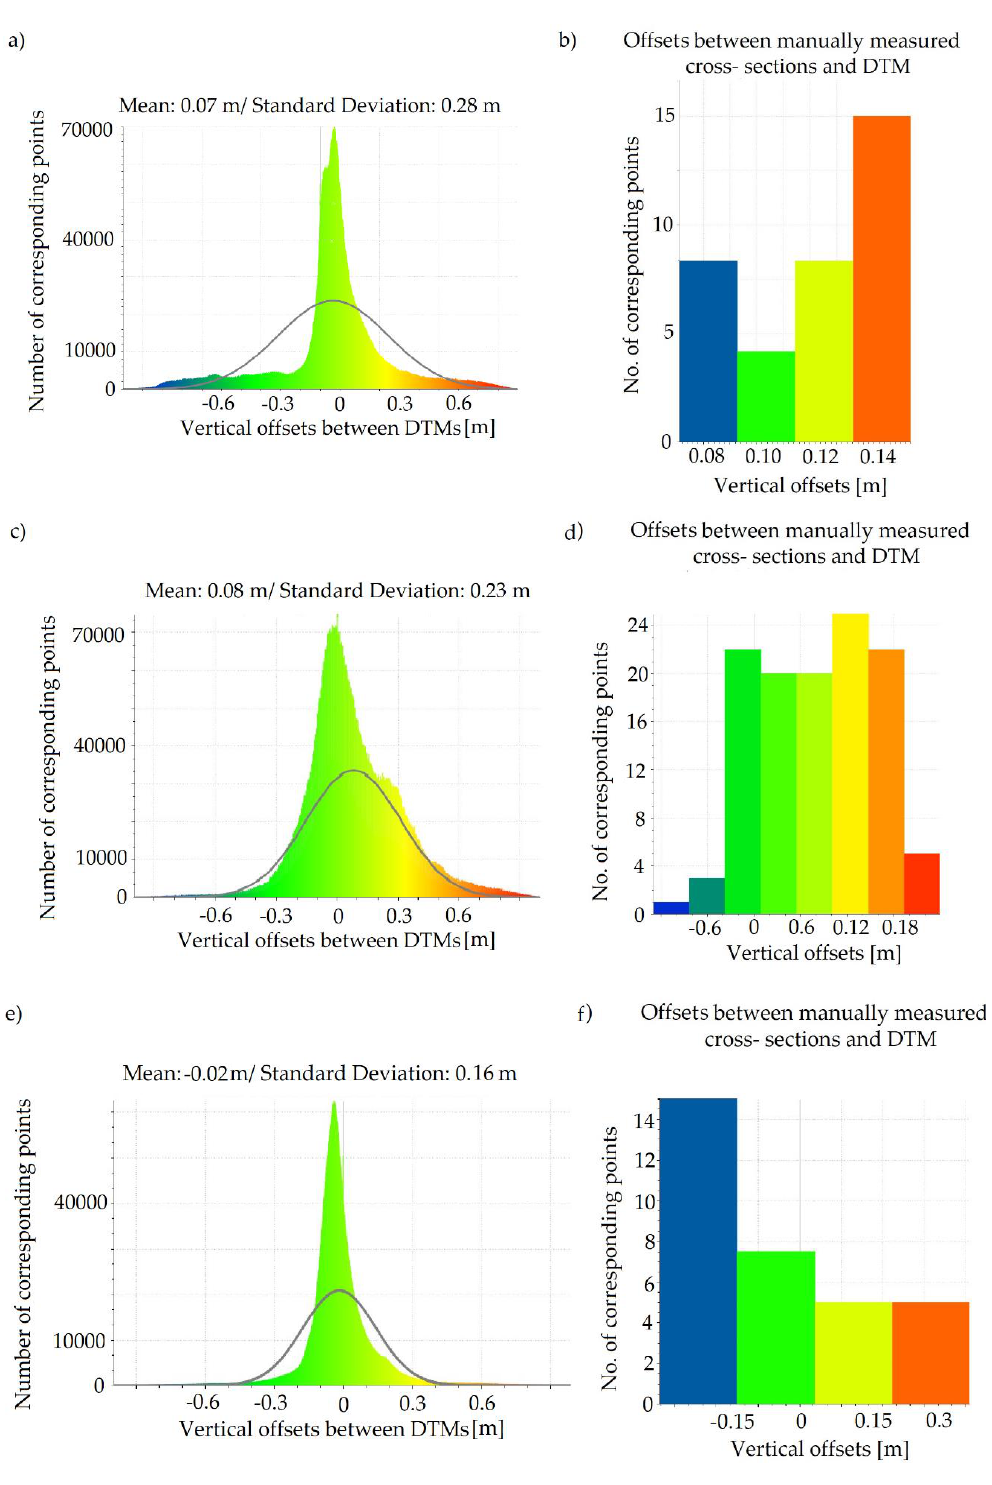
Figure 5. Analysis of the obtained bathymetric scanning material: ( a , c , e ) the distance graph of the measured vertical o ff sets between the Airborne Bathymetry Lidar (ALB) method Digital Terrain Model (DTM) versus the DTM from the Central Geodetic Centre in Poland; and ( b , d , f ) a comparison between the results of manual measurements as a vertical o ff set between the GPS RTK measured point and DTM from ALB, from ( a ) and ( b ) the first measurement; ( c ) and ( d ) the second measurement; and ( e ) and ( f ) the third measurement. The colour palette indicates values from the lowest (marked in blue) to the highest (marked in